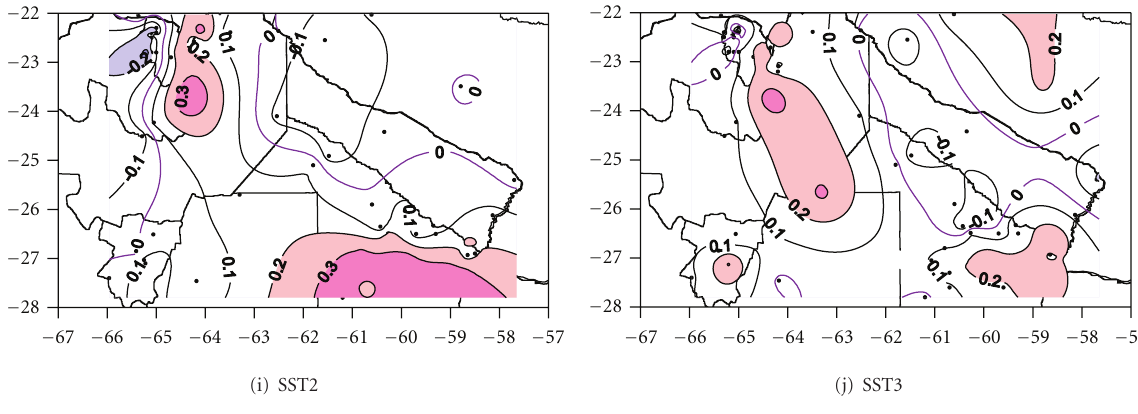
Figure 6: Idem Figure 3 for Spring (SON)